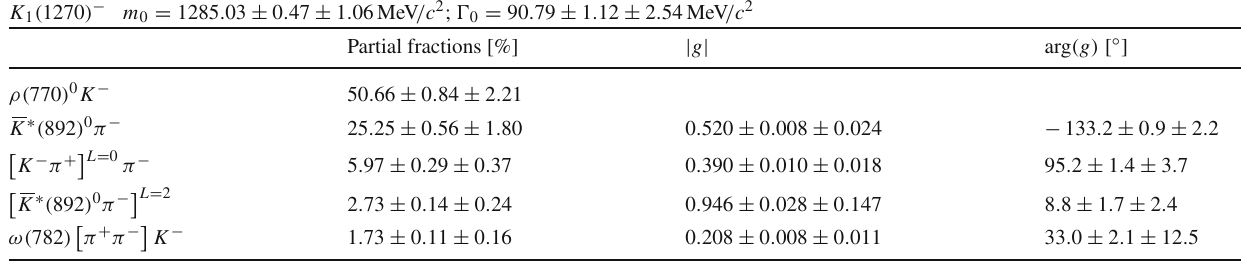
Table 21 Table of fit fractions and coupling parameters for the compo- nent involving the K 1 ( 1270 ) − meson, from the fit performed on the RS decay D 0 → K − π + π + π − . The coupling parameters are defined with